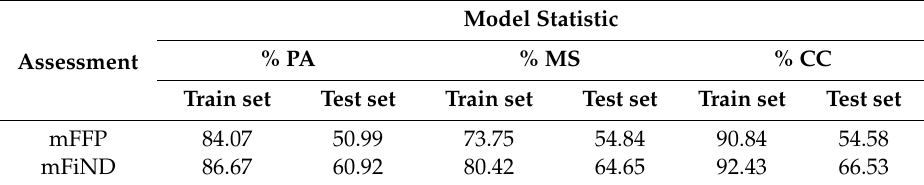
Table 1. Calculated model statistics of the supervised SOM model.